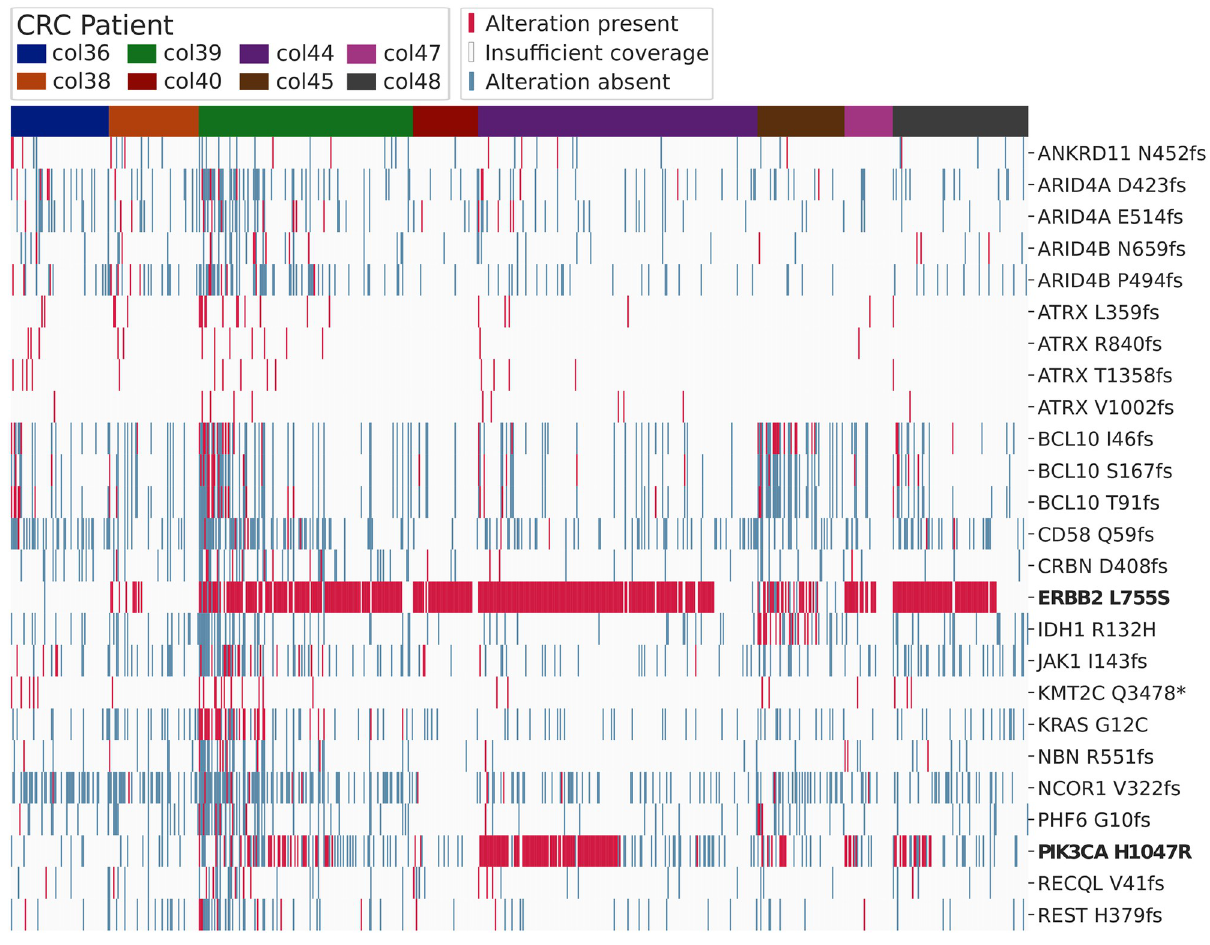
Fig 2. Heatmap indicating alteration status for 736 cells for the top 25 most frequent oncogenic, predicted oncogenic, and likely oncogenic alterations in the CRC dataset. Alterations are annotated using OncoKB. Absence of an alteration is noted when a cell has a read depth of at least 5 for all bases corresponding to the residue. For residues without an oncogenic alteration and with read depths less than 5 for all corresponding bases, the presence or absence of an alteration is not characterized (labeled as “Insufficient coverage”). Common recurrent driver mutations are shown in